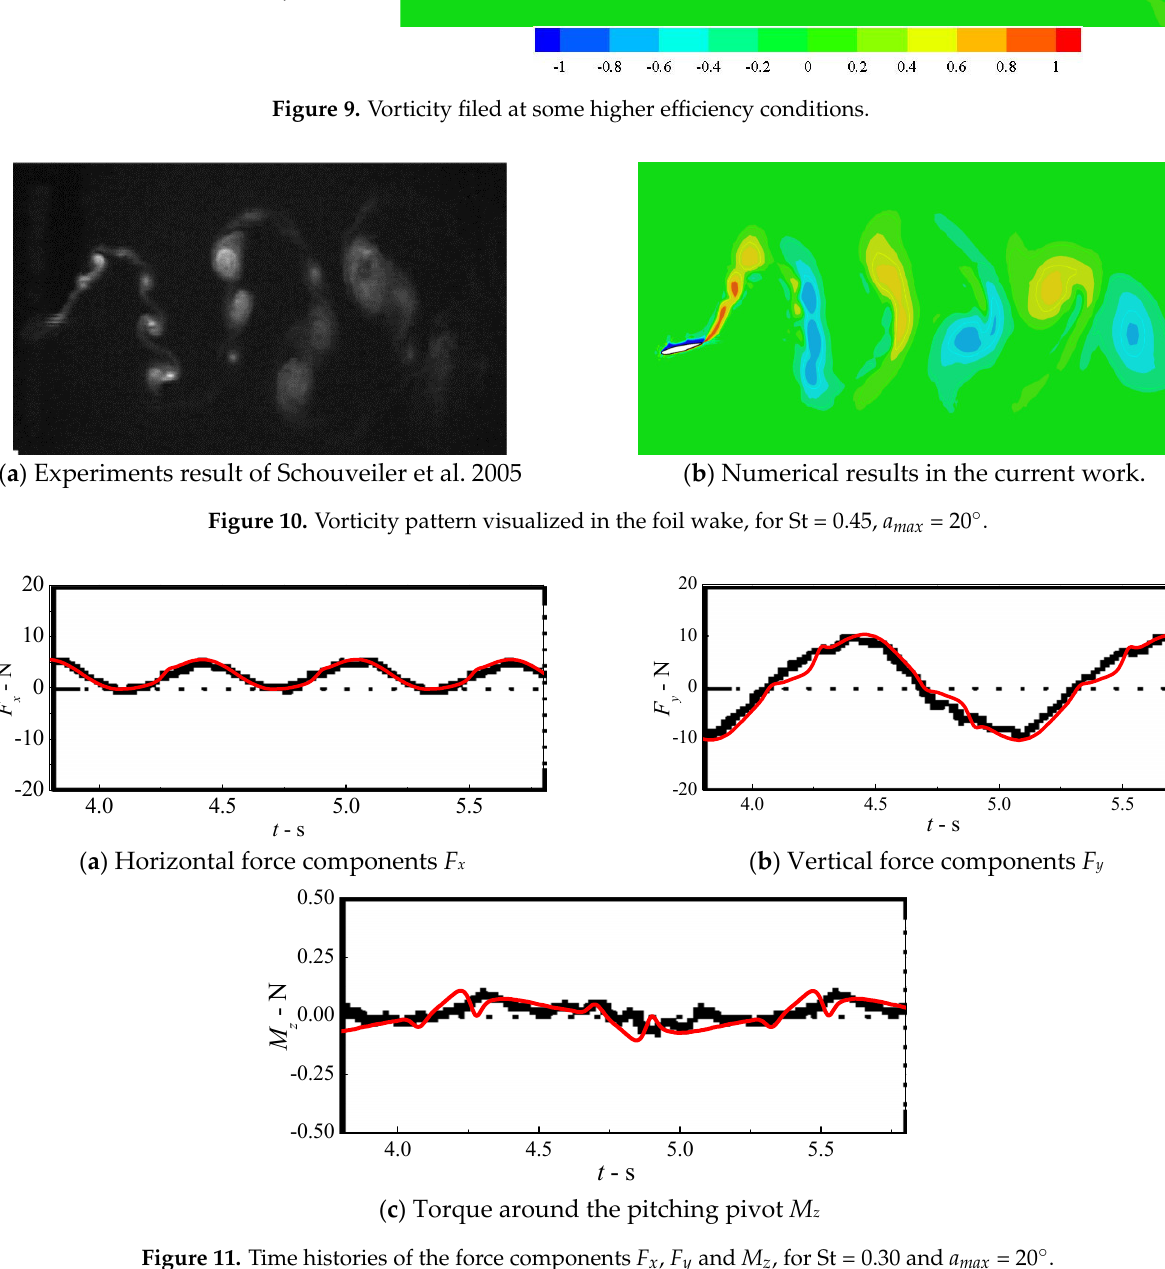
Figure 11. Time histories of the force components F x , F y and M z , for St = 0.30 and a max = 20°.